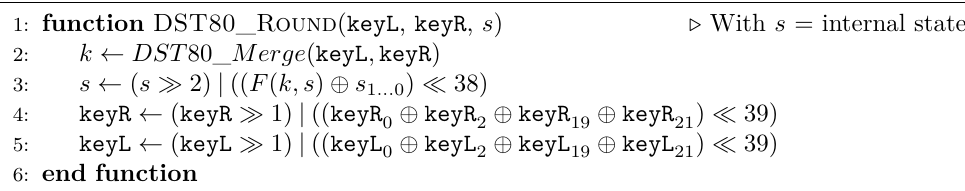
Algorithm 2 The DST80 round